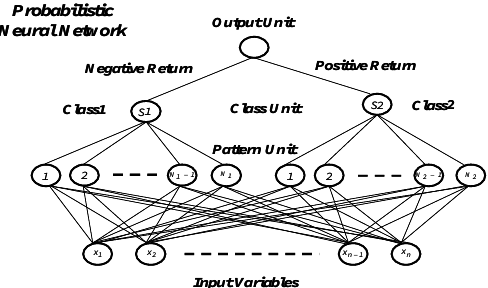
Fig. 1. A simple probabilistic neural